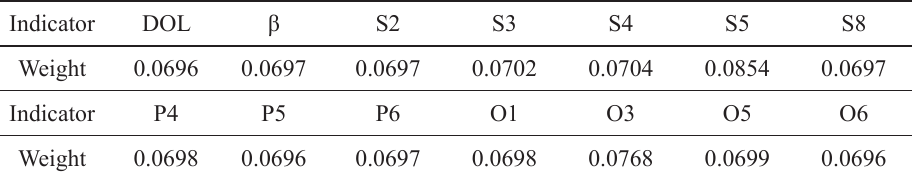
Table 5. The results of grey entropy